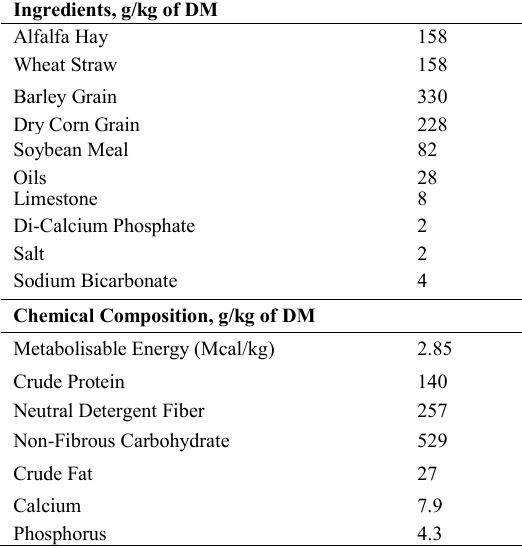
Table 1. Feed ingredients and chemical composition of basal experimental